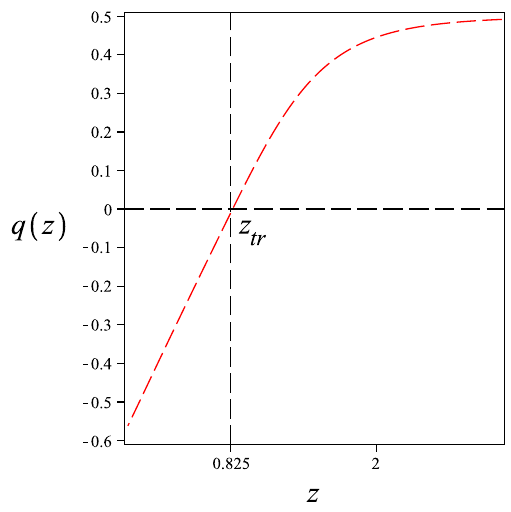
Fig. 4 Theplotofdecelerationparameter q ( z ) showsthedeceleration– acceleration transition